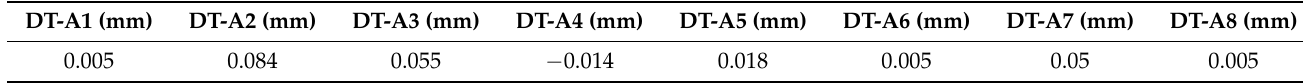
Table 7. Displacement of anchorage when introducing prestressing to the strands.